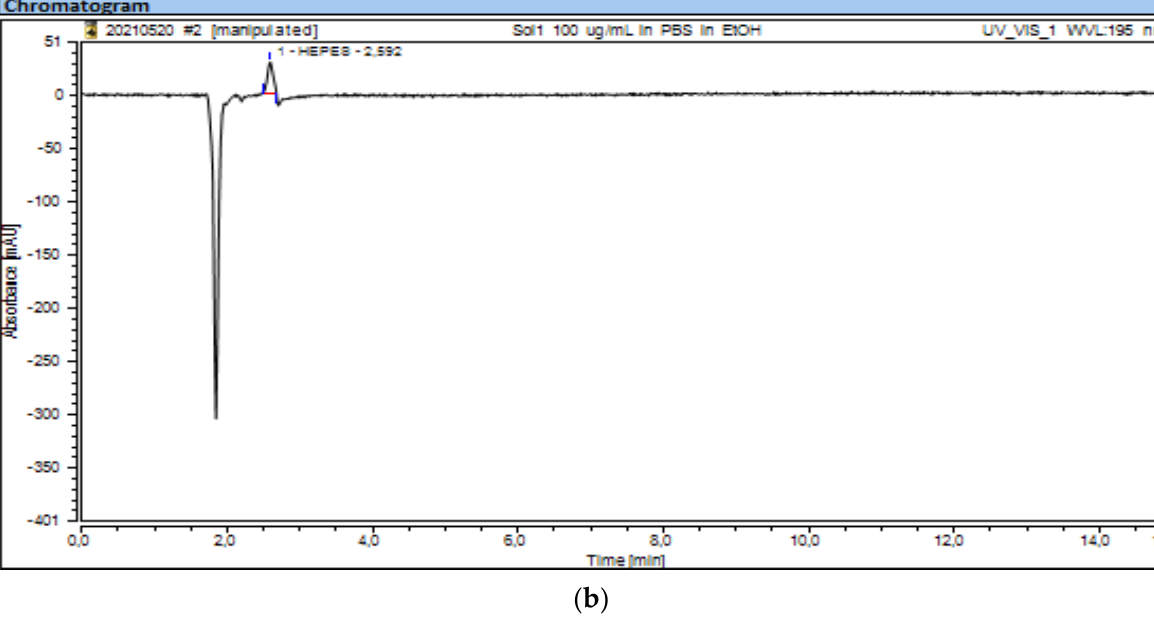
Figure 3. HPLC chromatograms: ( a ) blank; ( b ) sample of HEPES solution.